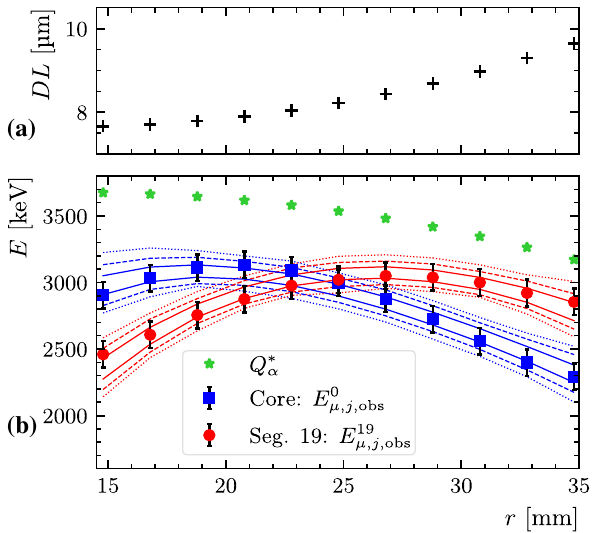
Fig. 17 a Dead-layer thickness as given by the fit to the data of the scan RSF, see Fig. 14a. b Deposited energy Q ∗ α corresponding to the depth of the dead layer and simulation results in form of (1 σ , 2 σ , 3 σ ) posterior-predictive credibility intervals (solid, dashed and dotted lines) for E 0 μ, and E 19 μ, compared to E 0 μ, and E 19 μ, of the scan j , sim j , sim j , obs j , obs RSF. The error bars do not show the uncertainty on the data points but σ